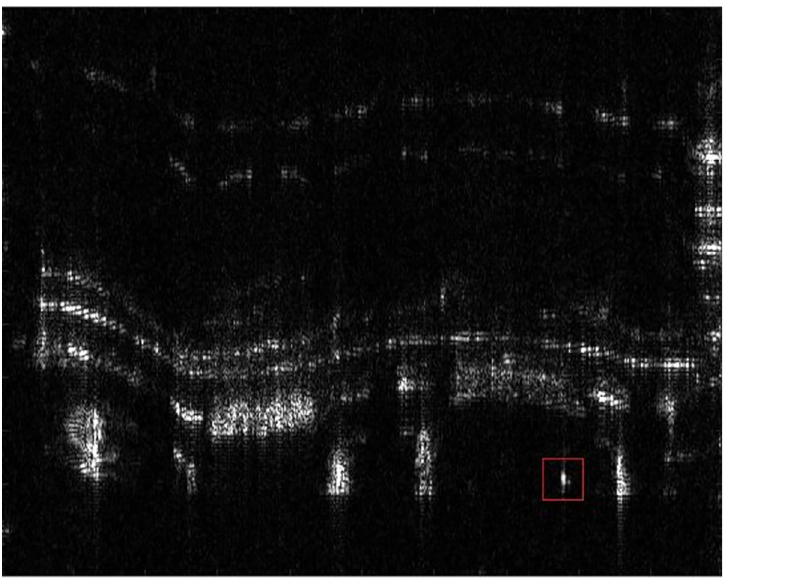
Fig 14. The real focused